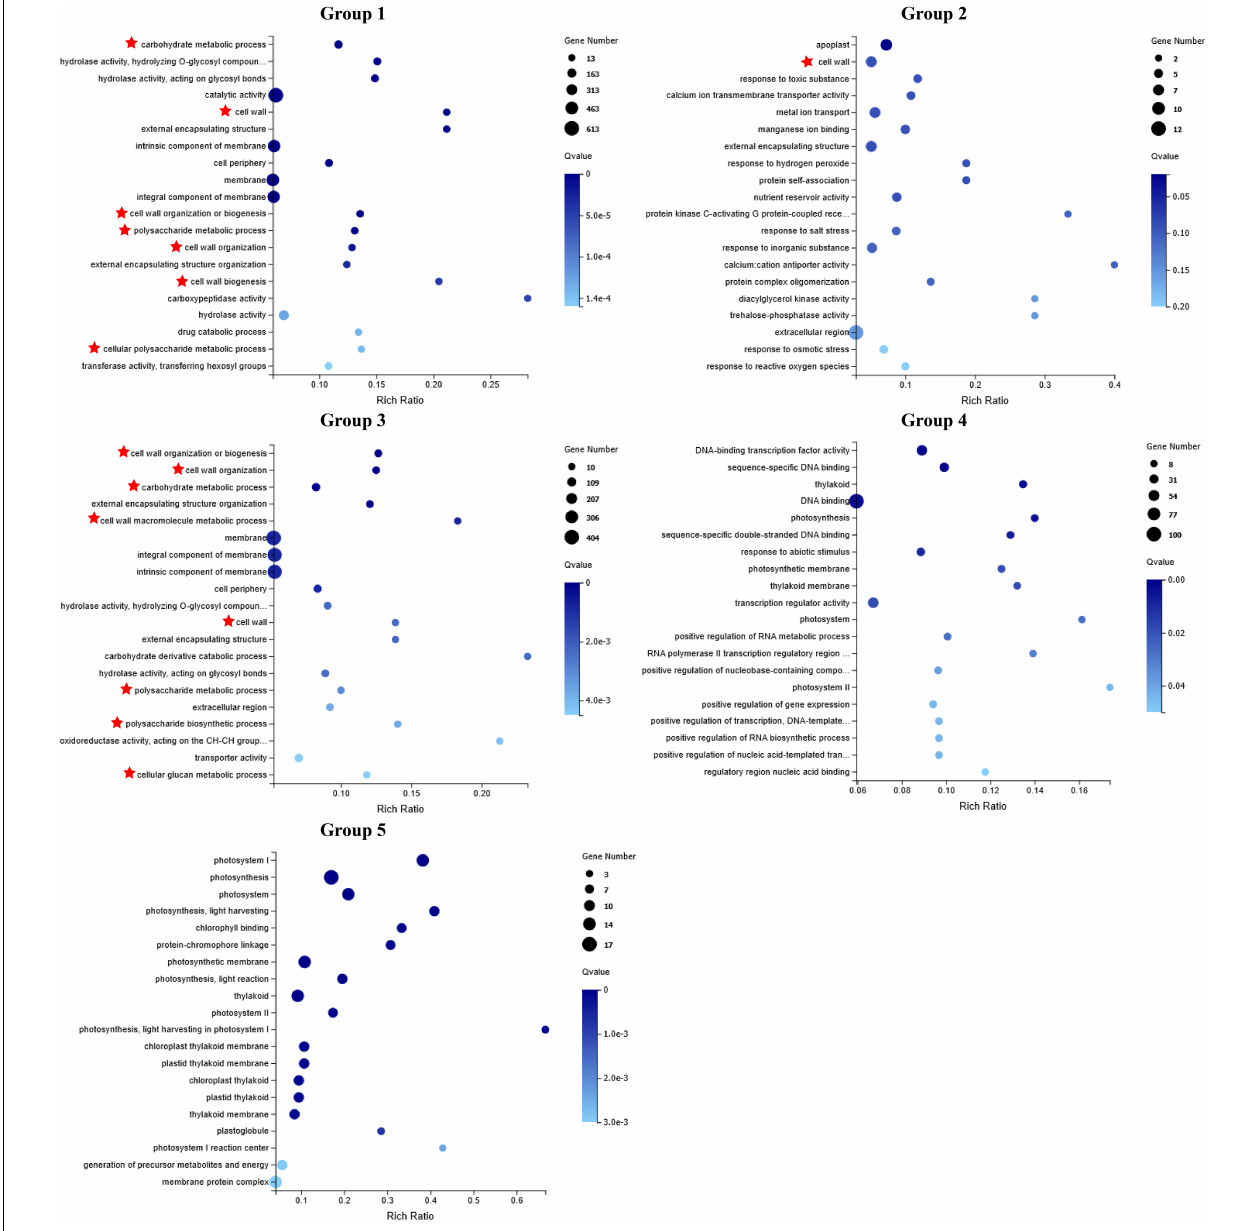
FIGURE 6 | Gene Ontology (GO) enrichment of selected category of differentially expressed genes (DEGs) based on Mfuzz cluster